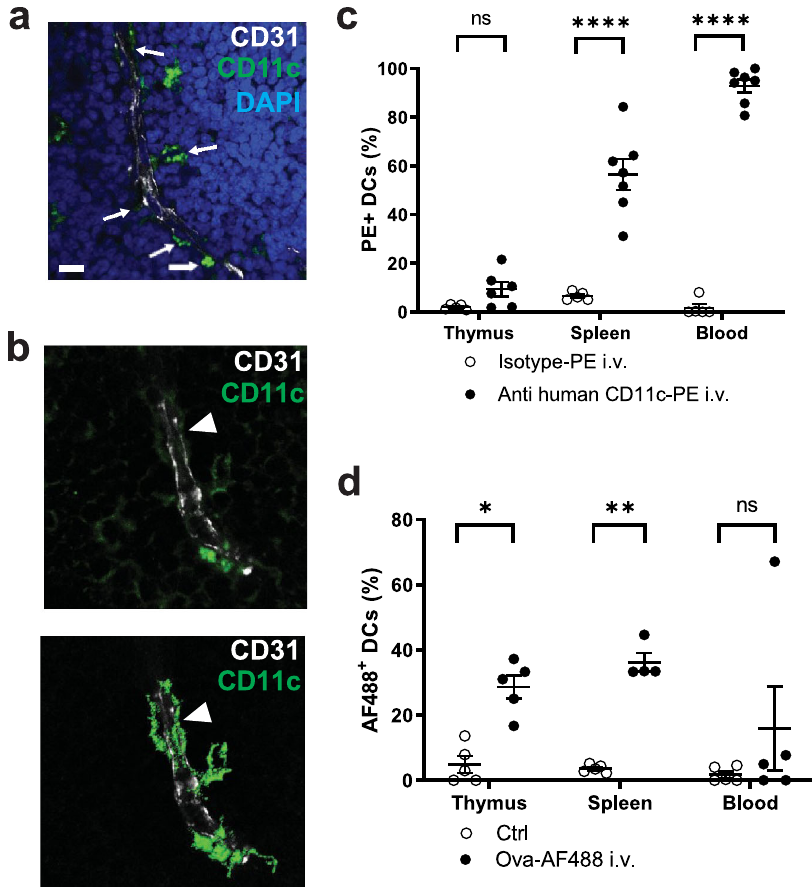
Fig. 9 Detection of TE-DCs in human thymi. a and b Representative confocal micrographs of fi ve human thymus grafts from humanized BLT mice show the close association of human hCD11c + DCs (green) with hCD31 + human, vascular endothelium (white, arrows), and nuclear DAPI staining (blue). The scale bar represents 10 μ m. b Higher magni fi cation images show a hCD11c + human DC that breaches the endothelial barrier (arrowhead). The upper panel shows hCD11c + DCs (green) and hCD31 + human, vascular endothelium (white), the lower displays a surface rendered illustration of hCD11c + DCs. The scale bar represents 10 μ m. c Humanized BLT mice were injected IV with anti-human hCD11c-PE or isotype-PE mAb, euthanized 2 mins later and PE + DCs from the animals ’ grafted human thymus, endogenous spleen, and blood were analyzed by fl ow cytometry. Each symbol represents an individual animal; open symbols indicate isotype-PE injected mice, closed symbols are anti-human CD11c-PE injected mice. n = 5 mice/group for isotype-PE i.v., n = 6 for CD11c-PE i.v. thymi and n = 7 for CD11c-PE i.v. spleen and blood each (two-way ANOVA). d Uptake of Alexa 488 labeled ovalbumin (Ova-AF488) by human DCs in BLT mice. In all, 5 min after IV injection of 100 μ g Ova-AF488, single-cell suspensions of the human thymus, mouse spleen, and blood were obtained and stained for hCD11c + DC. n = 5 mice/group except for n = 4 for Ova-AF488 i.v. spleen (two-way ANOVA). Bars and error bars represent mean ± SEM. * P = 0.0234; ** P = 0.003; **** P < 0.0001; n.s.: not signi fi